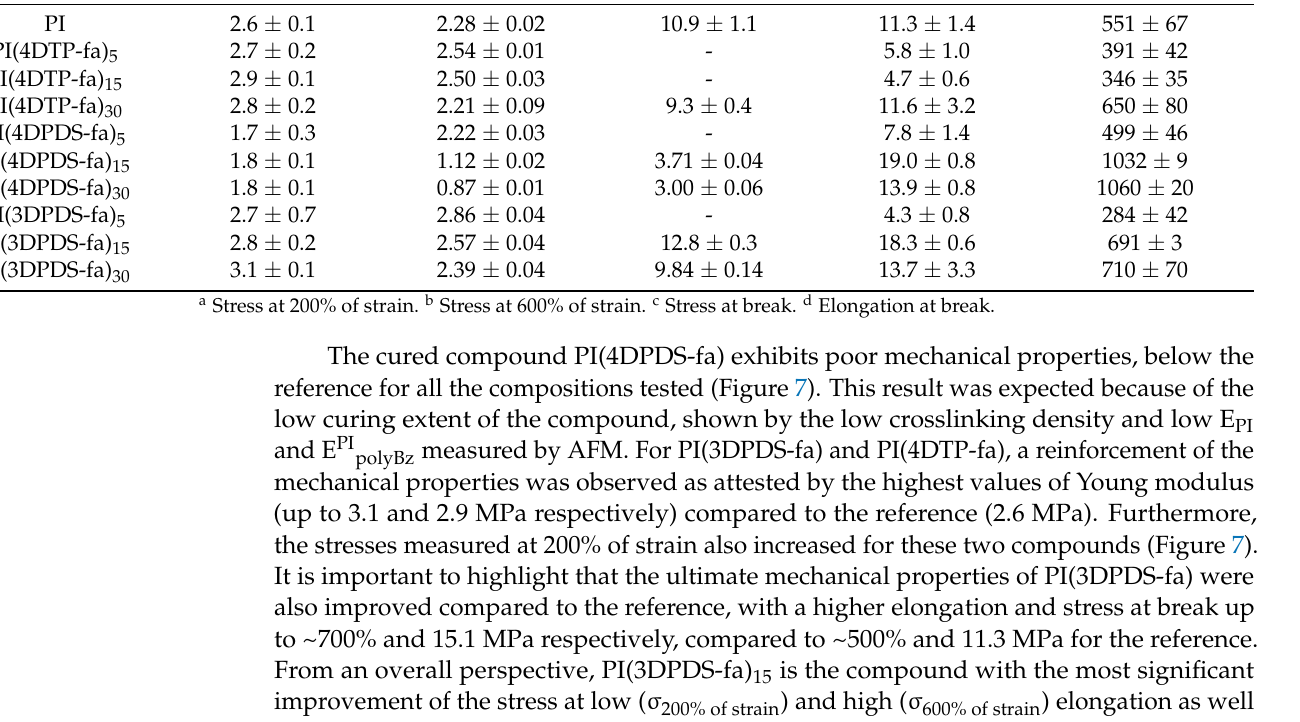
Table 4. Summary of the mechanical properties of the rubber compounds containing benzoxazines. Compounds with